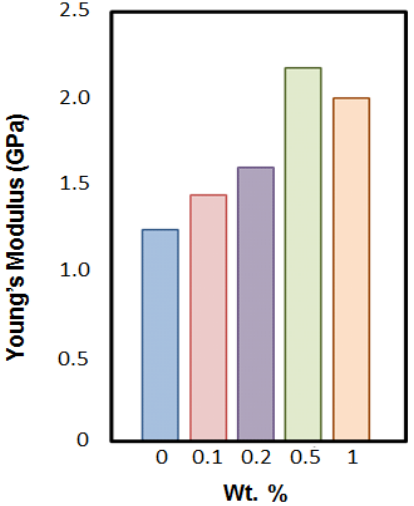
Figure 9. Young’s modulus vs. functionalized reduced graphene oxide (FRGO) concentration for epoxy + FRGO hybrids.